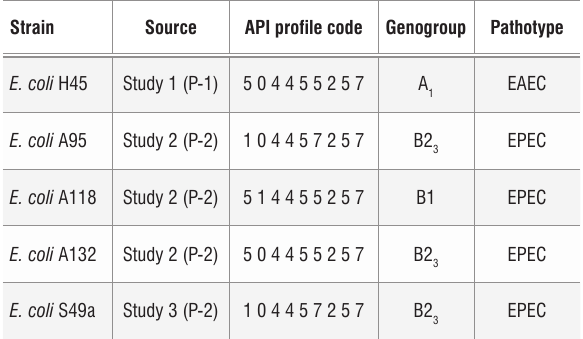
Intestinal pathogenic (InPEC) E. coli strains isolated Strain Source